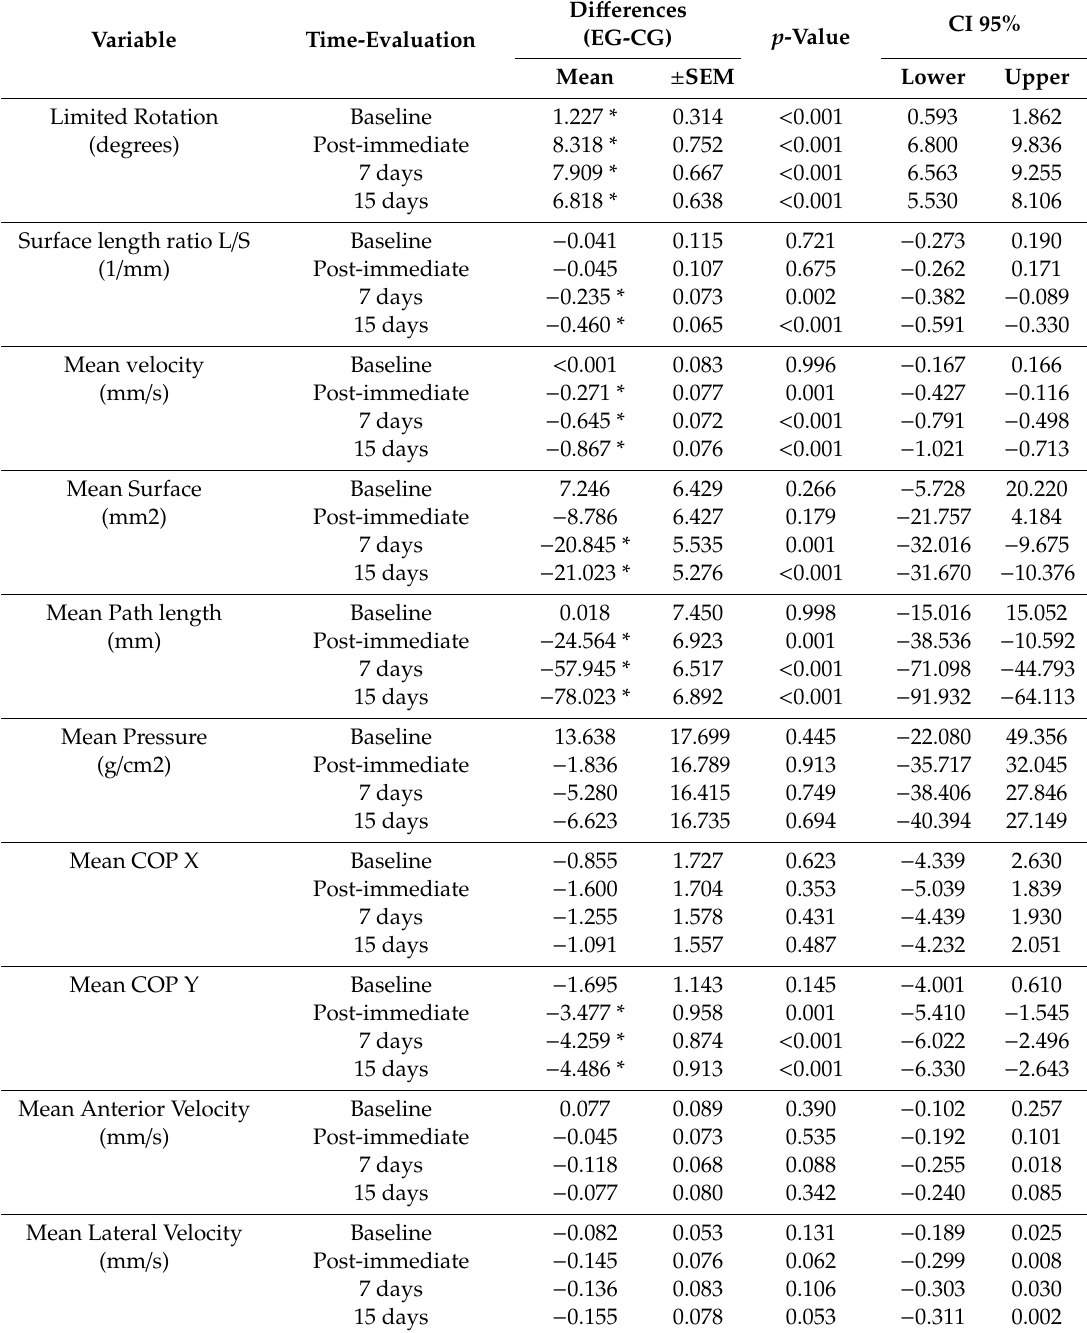
Table 3. Interaction between factors (time * group) showing the di ff erences by group at each evaluation (post hoc Sidak